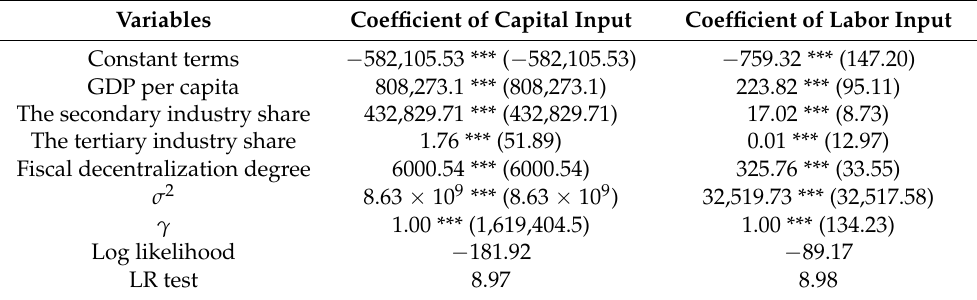
Table 2. The regression results of SFA model in the second